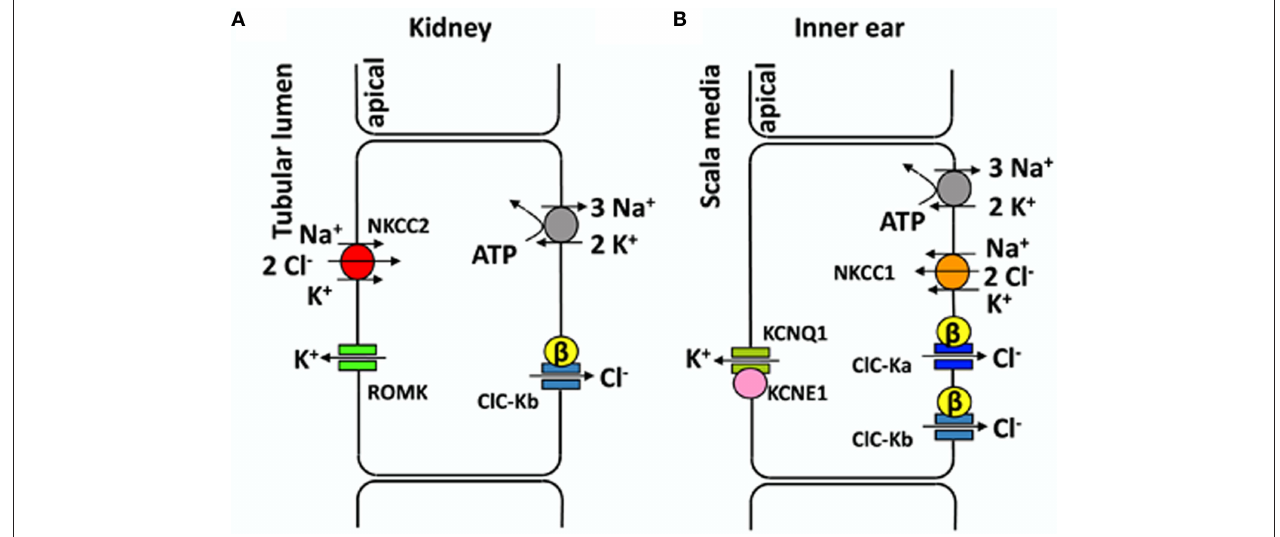
Figure 1 | Transport models for NaCl reabsorption in the TAL (A) and for transepithelial K + transport in the inner ear (B). (A) Schematic representation of an epithelial cell from the thick ascending limb of Henle’s loop. All transporters involved in NaCl reabsorption are drawn in different colors. (B) Schematic representation of marginal cell from the stria vascularis (for simplicity other epithelial cell layers are not shown). See text for